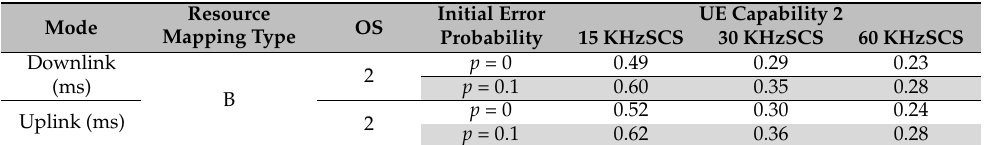
Table 9. User plane delay for 5G-NR